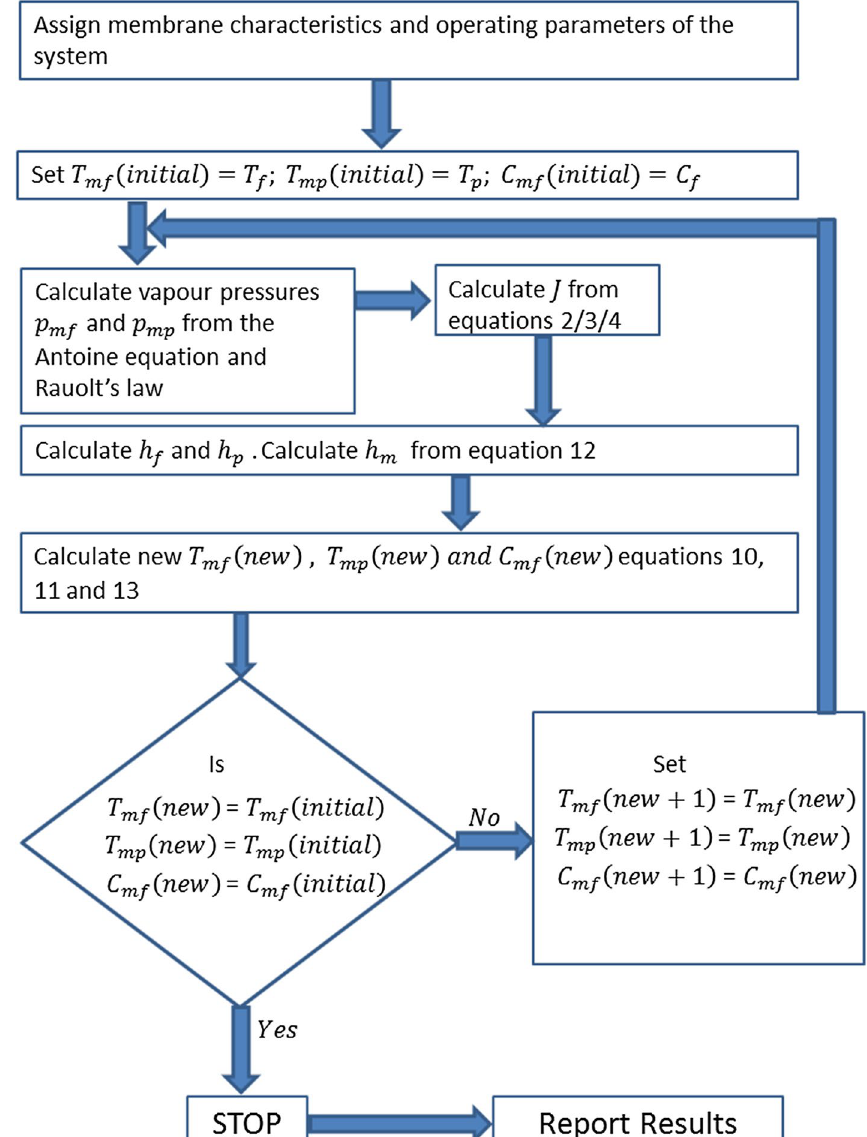
Fig. 4 Computational algorithm to numerically solve the mass and heat transfer in DCMD